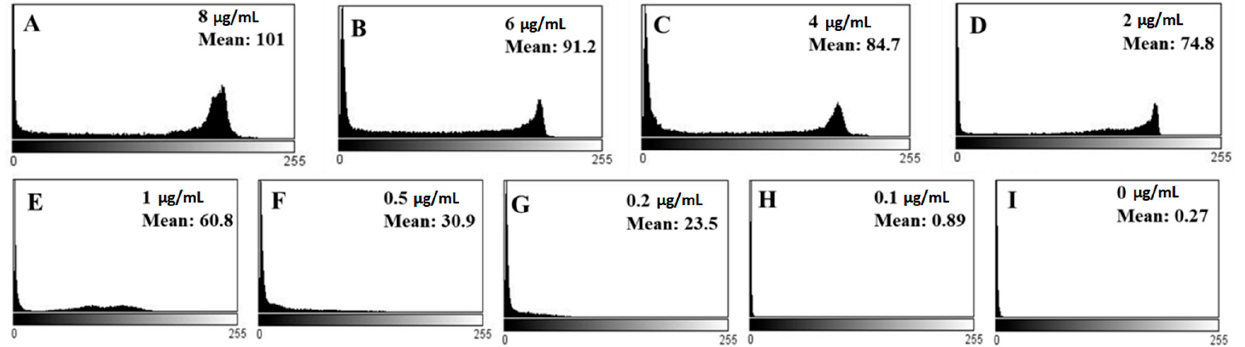
Figure 7. ( A – I ) are showing mean gray values corresponding to different optical images of LCs given in Figure 6.